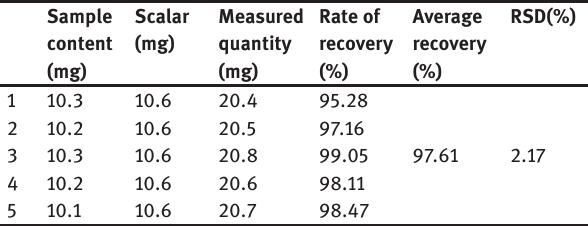
Table 4: Experimental results of recovery of total flavonoids